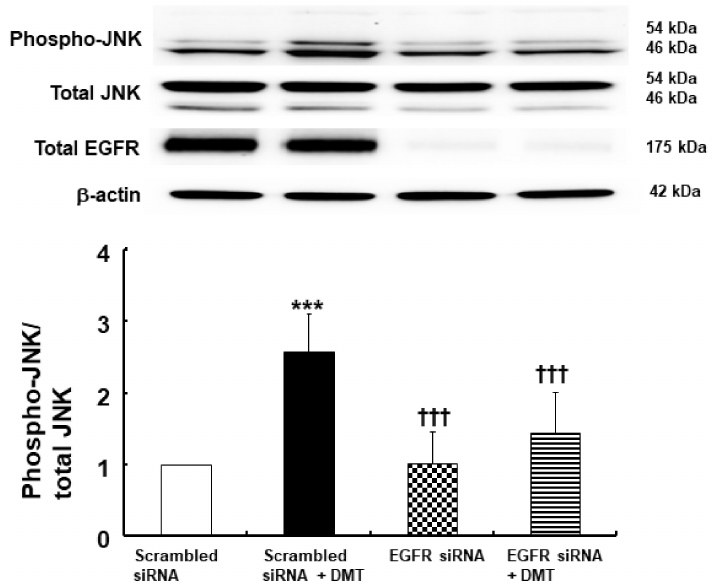
Figure 5. Effect of dexmedetomidine (DMT, 10 − 6 M) on c-Jun NH 2 -terminal kinase (JNK) phospho- rylation in rat aortic vascular smooth muscle cells transfected with scrambled siRNA and epidermal growth factor receptor (EGFR) siRNA. Data (N = 4) are shown as mean ± SD. N indicates the number of independent experiments. *** p < 0.001 versus scrambled siRNA. ††† p < 0.001 versus scrambled siRNA + DMT.